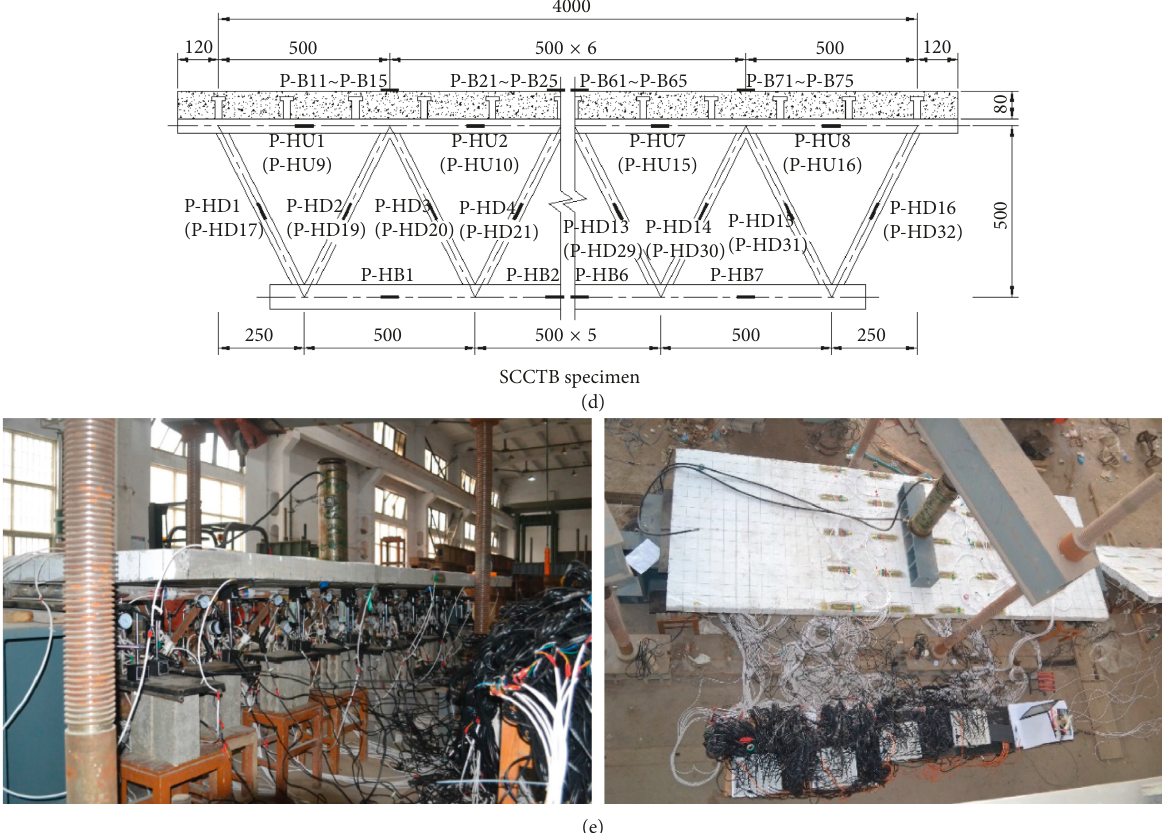
Figure 3: Arrangement of the measurement points for the SCCTB specimens. (a) Simply support. (b) Dial gauges. (c) LVDTs. (d) Strain gauges. (e) Photos of SCCTB specimens.